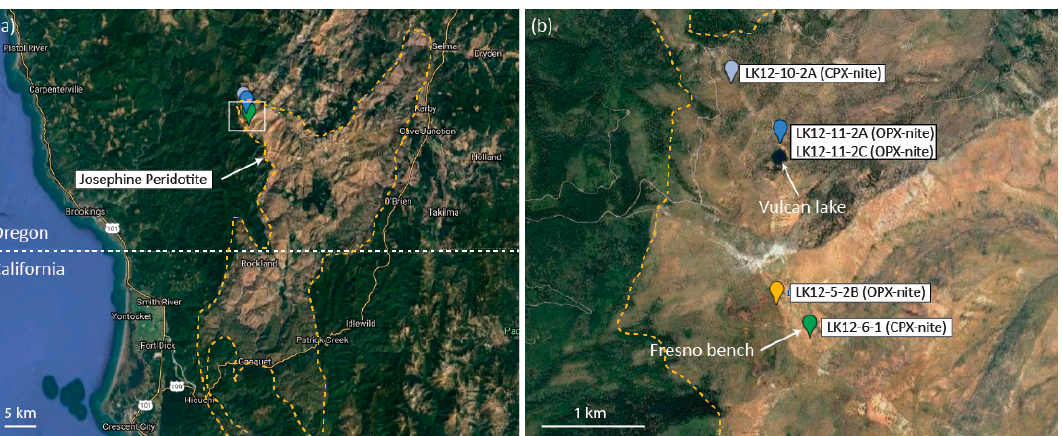
Figure 1. ( a ) Regional map of the Josephine peridotite. The white rectangle indicates the location of ( b ) inset, and dotted orange line indicates the approximate contours of the Josephine peridotite. ( b ) Location of the pyroxenite samples, collected in the northeastern portion of the Josephine peridotite.